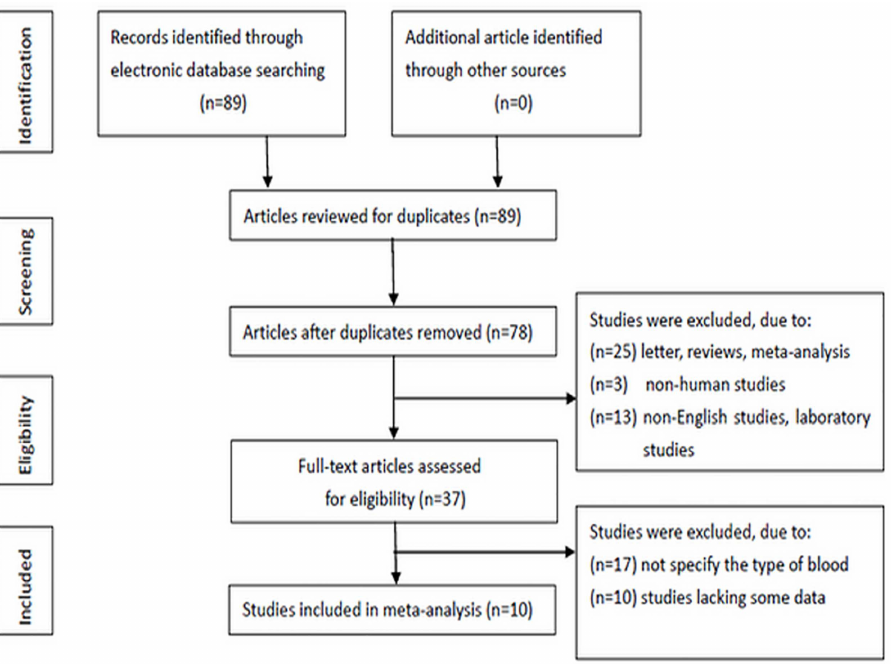
Fig 1. Flow chart showing the study selection procedure.